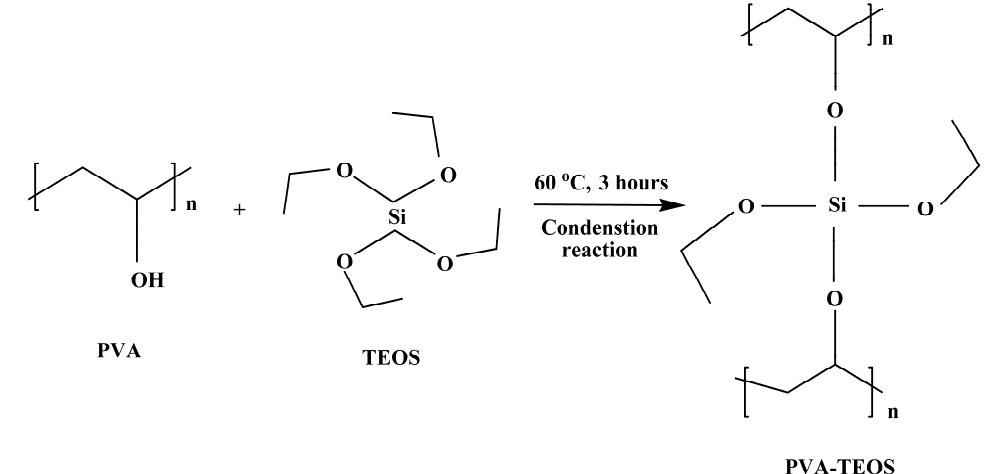
Figure 12. Possible scheme of interaction between PVA and TEOS